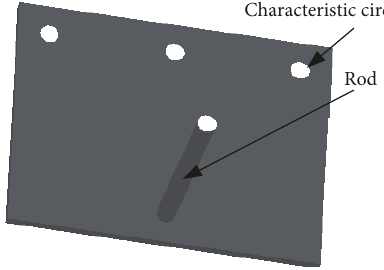
Figure 6: Marker of the vision